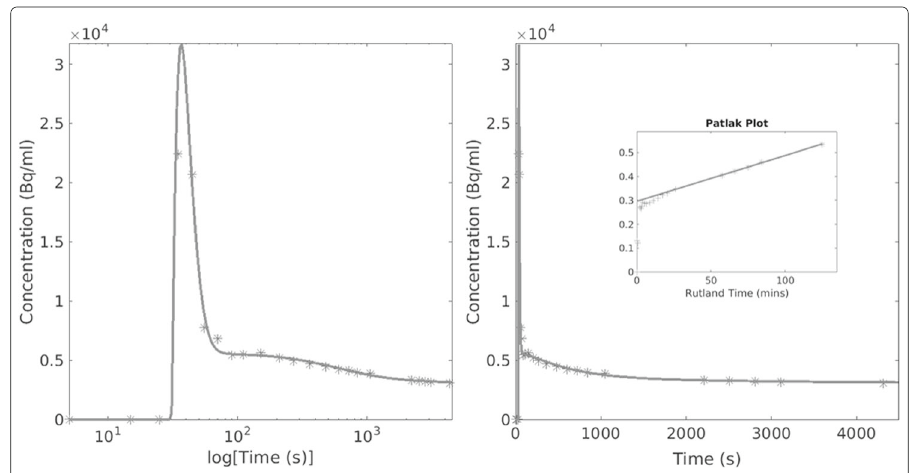
Fig. 6 Example patient TTAC and fits with using combined-CT reconstructions for analysis. An FDG example TTAC with associated compartment model and Patlak-Rutland (inset) fits. This is the same FDG patient as shown in Fig. 3 for comparison. Both columns show the same data using different time axes as before (Fig.